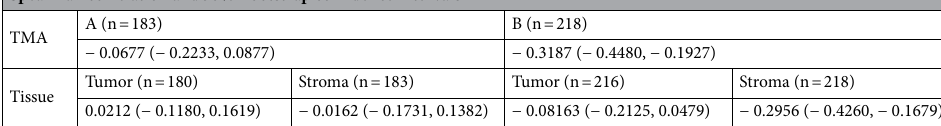
Table 2. Spearman rank correlation and 95% Bootstrap confidence intervals for correlation between CAIX and CD8 + T cell counts for different tissue samples and stratified by